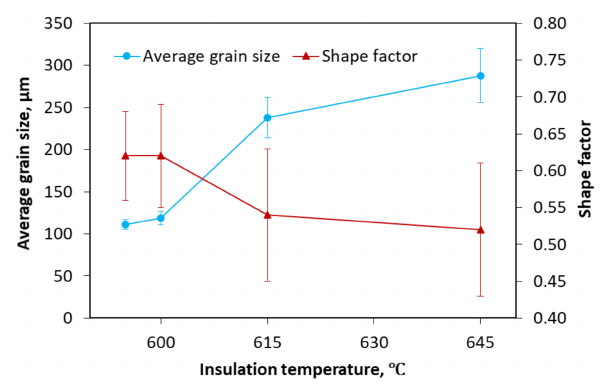
Figure 6. E ff ects of insulation temperature on the average grain size and shape